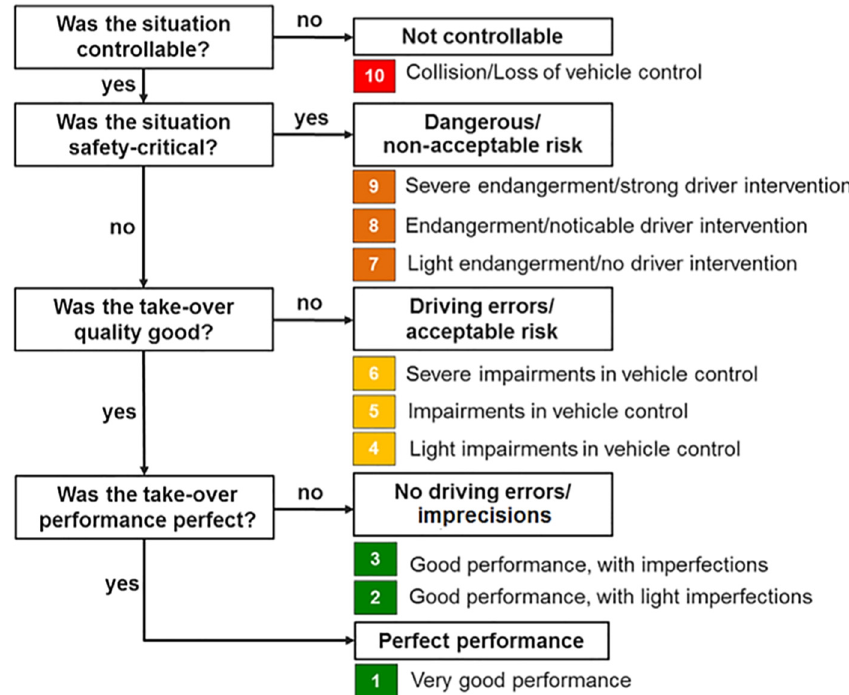
Figure 6: Overview of TOC - rating process [ 20 ]